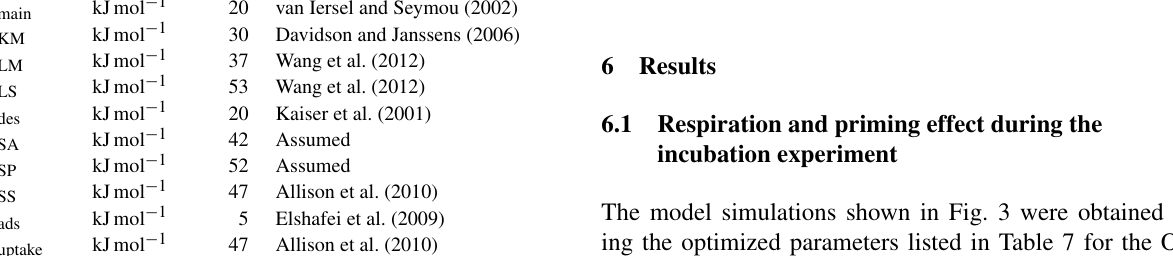
Table 4. List of parameters with prescribed values. Parameters Units